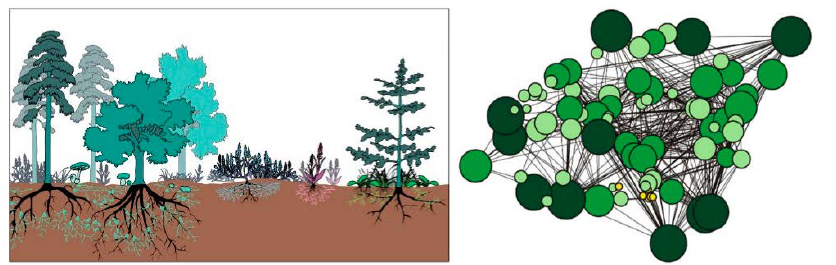
Figure 3. MN involves plants of different species and sizes as well as shrubs, and the Topology MN.